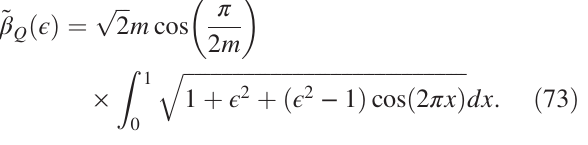
~ β ϵ Þ [cf. Eq. (74)] and FIG. 4. For m ¼ 2 , the curves Q ð ~ β ϵ Þ ¼ 2 max f 1 ; j ϵ jg . These capture the behavior of the non- C ð locality of the ground state of Eq. (64) in the limit of large n . ~ β ϵ Þ is above ~ β ϵ Þ (blue region), nonlocality is Whenever Q ð C ð detected. Otherwise (red region) a more stringent test is needed or the state admits a local hidden variable model. The inter- ≈ 0 . 327618 and section points between the two curves are ϵ (cid:3) ϵ (cid:3) ≈ 3 . 05234 .